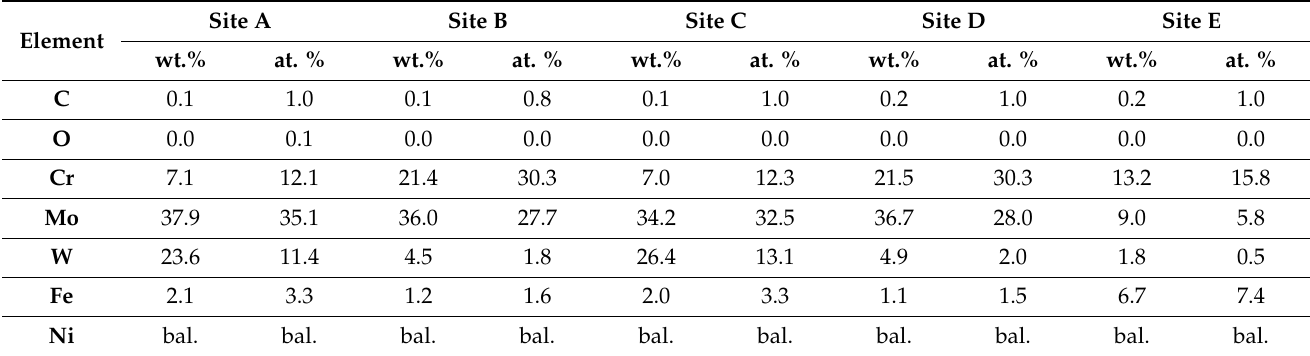
Figure 3. The SEM-BSE photos showing the precipitates in the C-276 pipe and the corresponding chemical compositions determined by EPMA at the specific sites are listed in Table 2: ( a ) the intragranular and ( b ) the intergranular precipitates. Table 2. Chemical compositions of sites A–E determined by EPMA in Figure 3.